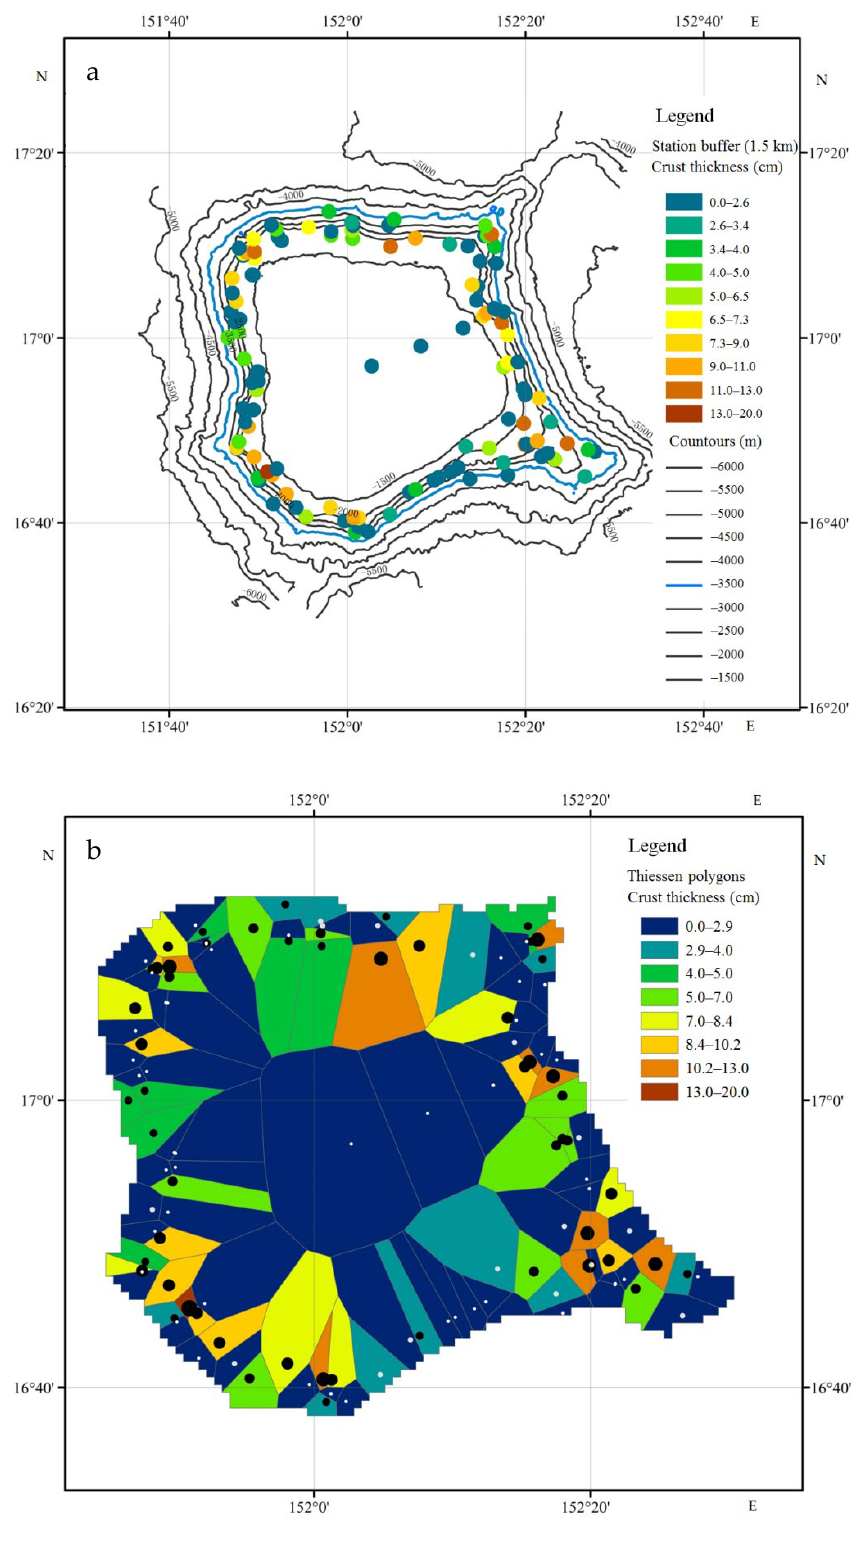
Figure 8. Geostatistical unit division using the adjacent area method: ( a ) Station buffer division and area assignment; ( b ) Thiessen polygons division and area